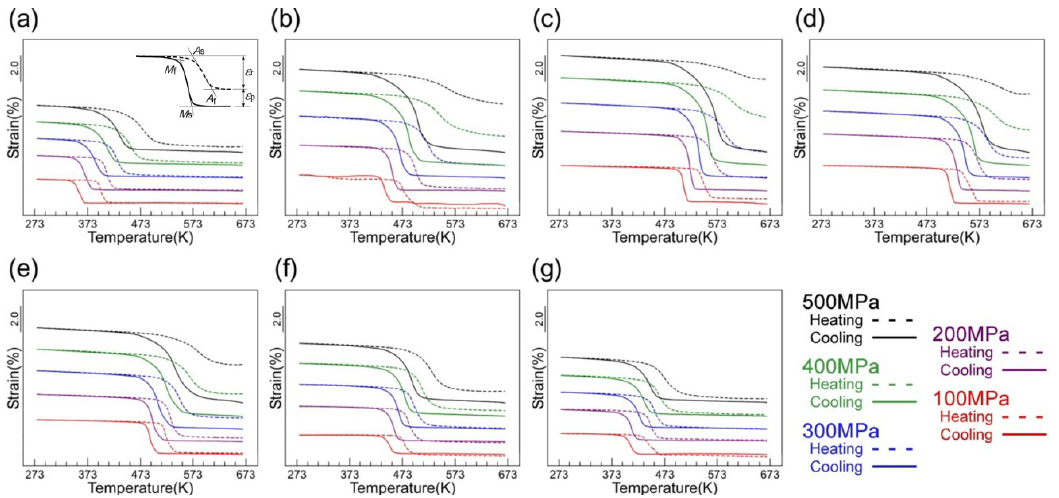
Figure 10. Strain–temperature curves of the (49–52)Ti alloys under various applied stresses. ( a ) 49Ti alloy; ( b ) 49.5Ti alloy; ( c ) 50Ti alloy; ( d ) 50.5Ti alloy; ( e ) 51Ti alloy; ( f ) 51.5Ti alloy; ( g ) 52Ti alloy.